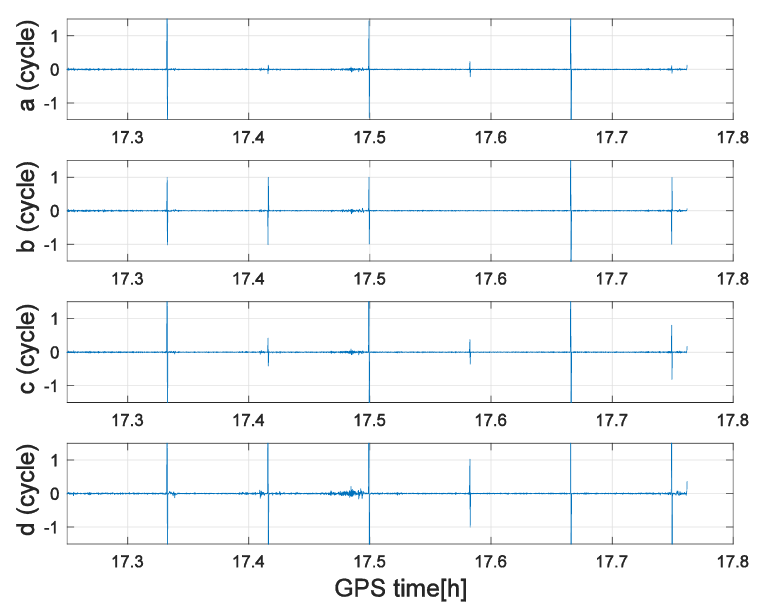
Figure 7. Cycle slip detection results for GPS PRN 9 using STG combinations in Equations (10) – (13), denoted by ( a – d ), respectively, with simulated cycle slip pairs at GOCE on 21 November 2009.